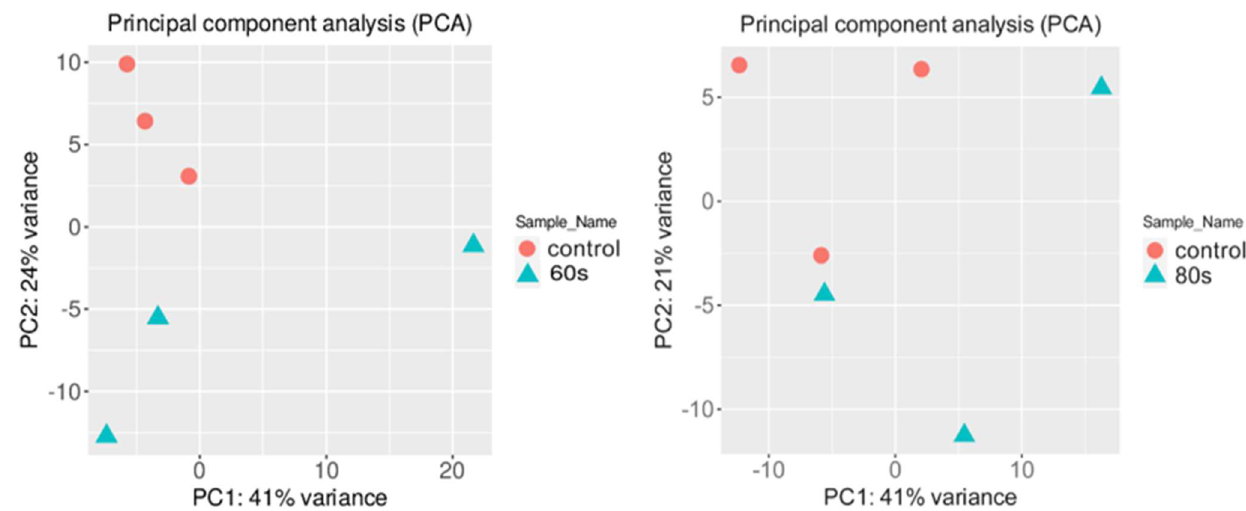
Figure 2. Principal component analysis (PCA) conducted on the normalized gene expression values of the 60 s ( left ) and 80 s ( right ) samples. X − and Y − axes show PC1 and PC2, respectively, with the amount of variance contained in each component, which is 41% and 24% for 60 s and 41% and 21% for 80 s, respectively. Each point in the plot represents a biological replicate, representing 30 seedlings, with a total of 6 biological replicates in the plot. Symbols of the same colors are replicates of the same experimental group where orange represents the control, which are untreated A. thaliana seeds grown into seedlings, and blue represents either 60 or 80 s plasma-treated A. thaliana seeds grown into seedlings.